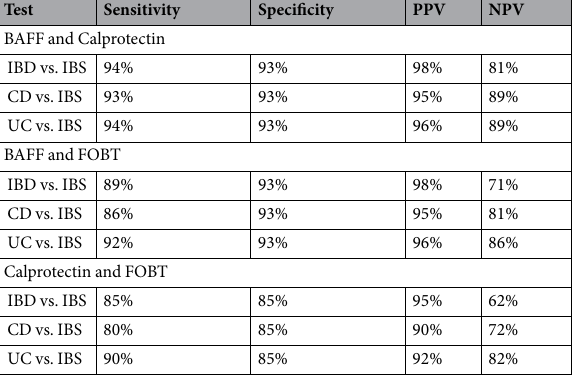
Table 4. Test Performance of Combined Faecal Markers. PPV, positive predictive value; NPV, negative predictive value.